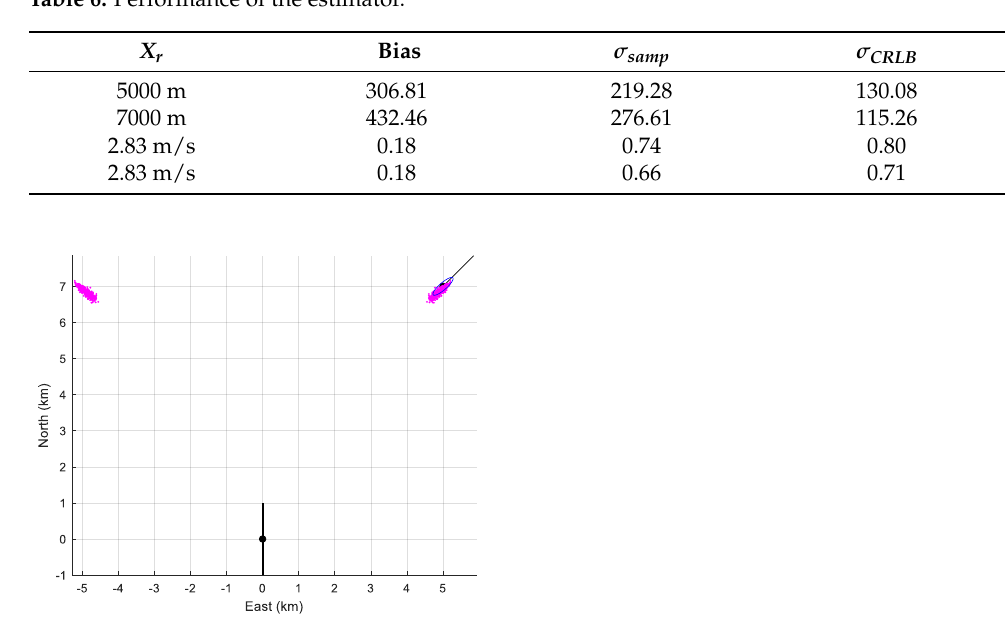
Table 6. Performance of the estimator.